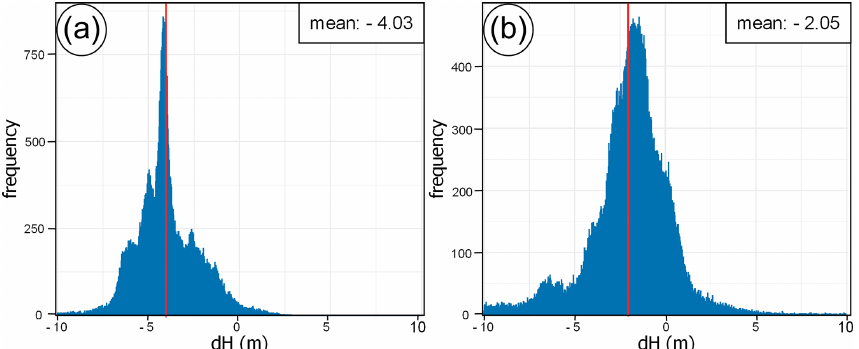
Figure 15. Histograms of TanDEM-X DEM minus IceBridge ATM differences for October 2014 campaigns at the (a) South Pole and (b) Recovery